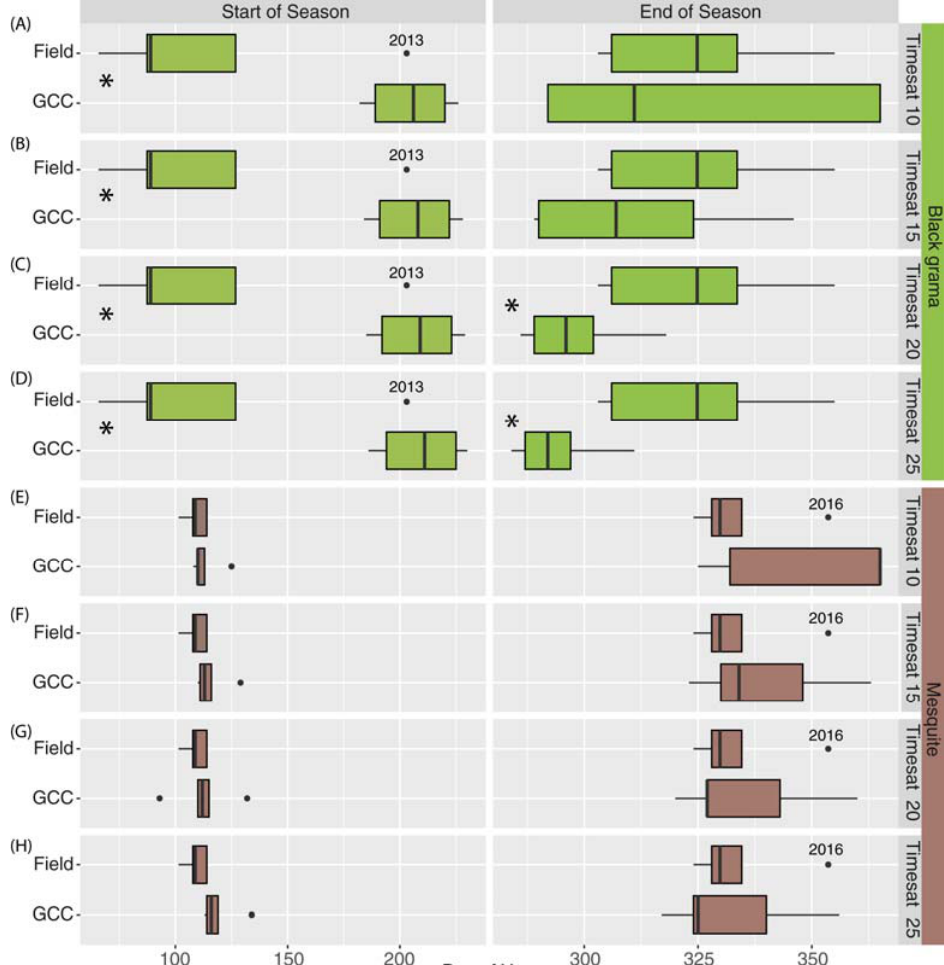
Figure 5. Boxplots representing field-observed and phenocam-derived GCC SOS and EOS dates for: black grama grass ( A – D ); and mesquite shrub ( E – H ) ROIs. Comparisons with significant differences using a paired t-test are noted with an asterisk. In box plots, the middle vertical black line represents the median date and horizontal lines denote the min and max date.